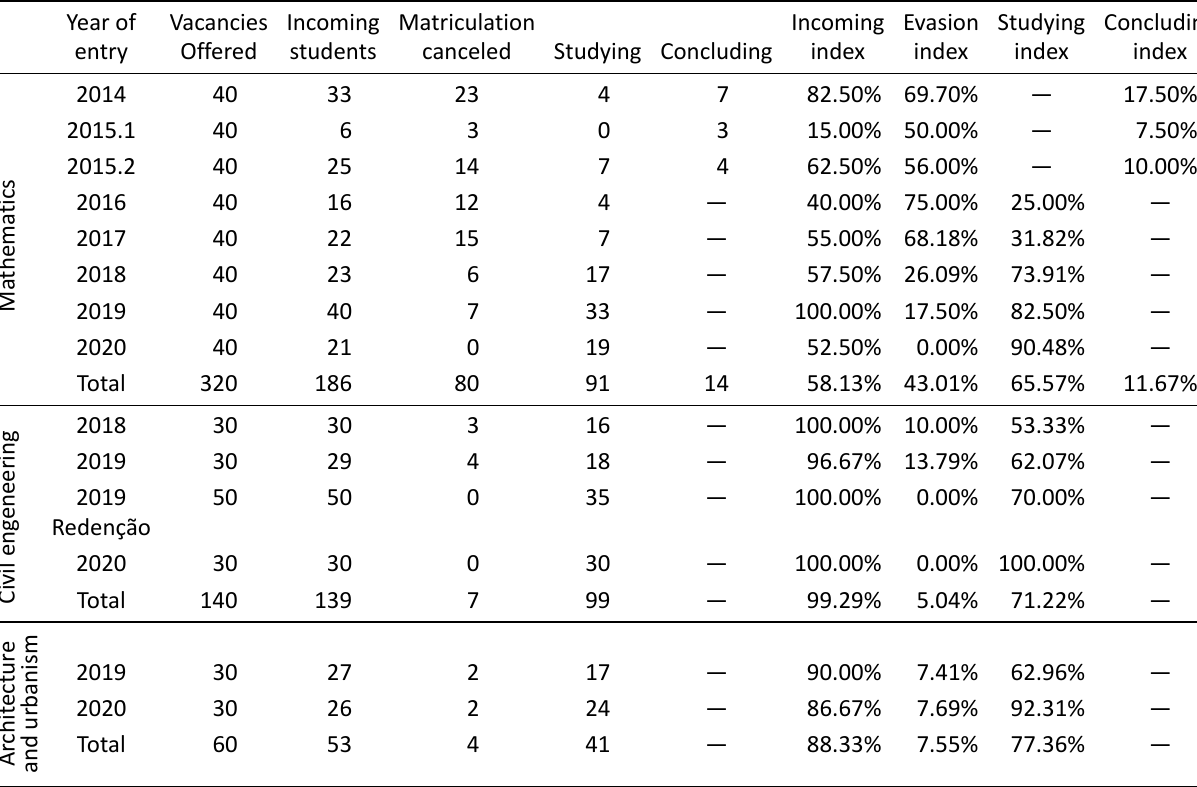
Table 3. Classes of IEA/Unifesspa in